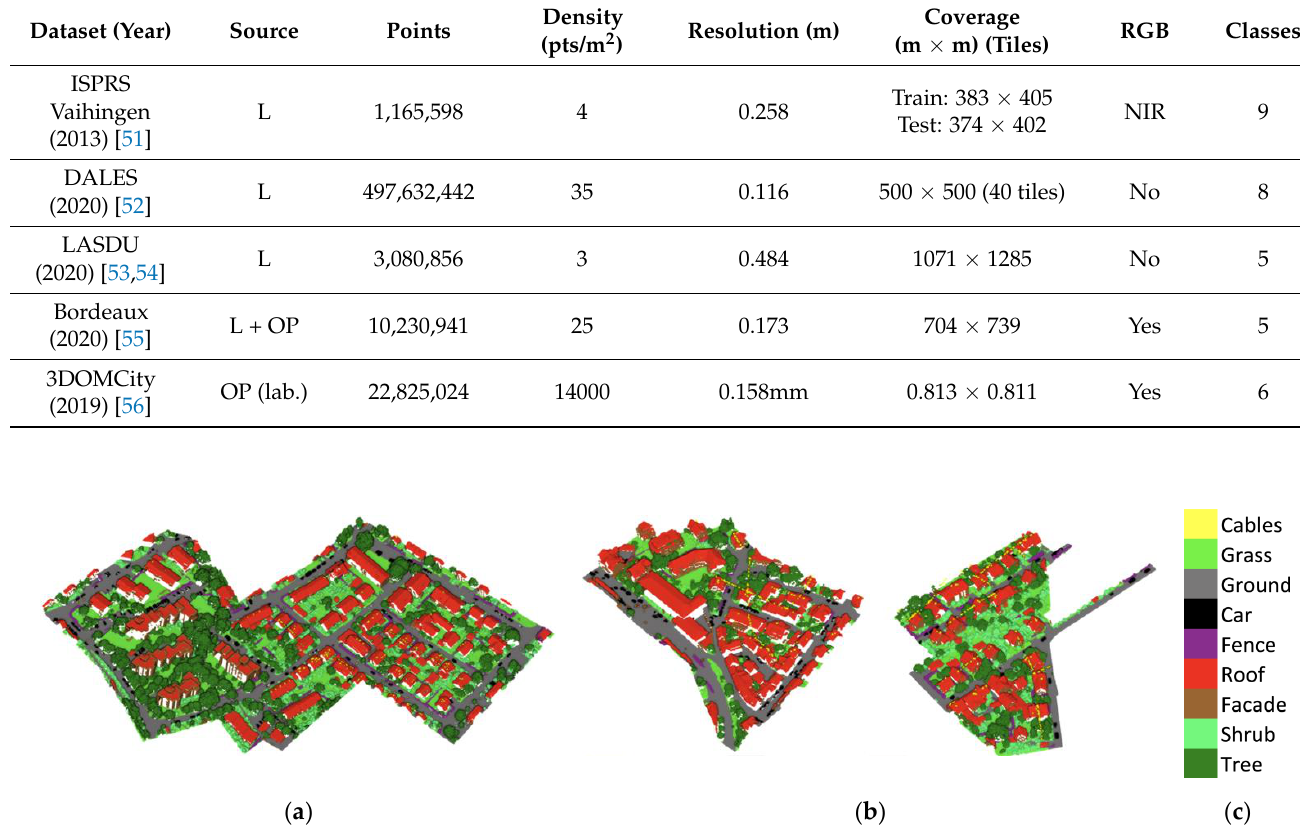
Table 2. Summary of the used datasets (L: LiDAR, OP: Oblique Photogrammetry, lab: laboratory).